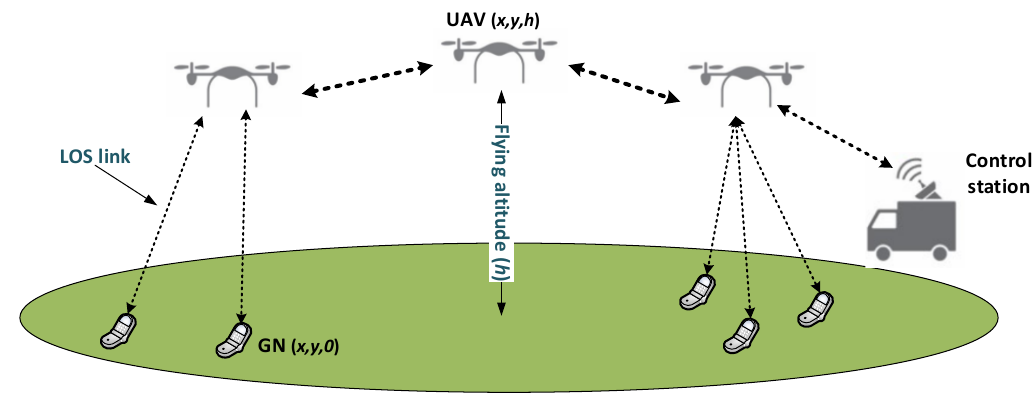
Figure 1. System model